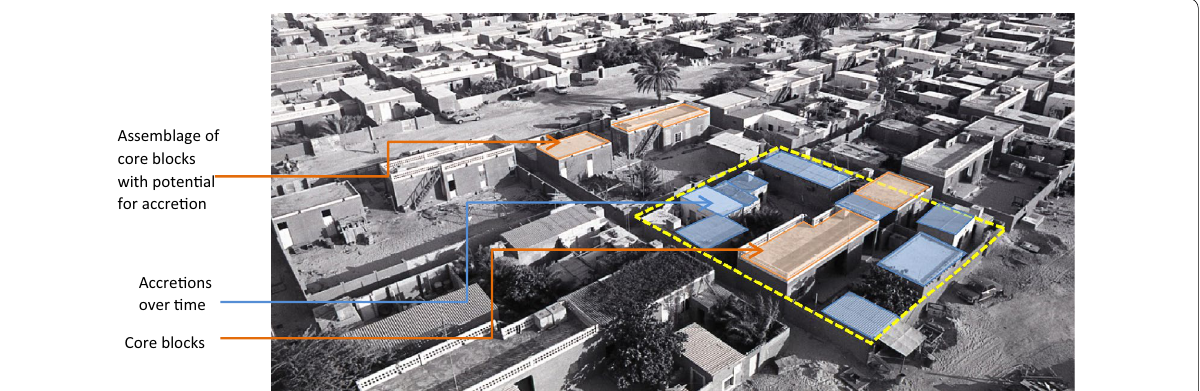
Fig. 4 Composite and accretive sha’abi Houses, Abu Dhabi in 1974. Note the potentialities of spatial accretion over time. Photo: Radboud Universiteit © Gerard Klijn/Katholiek Documentatie Centrum Nijmegen